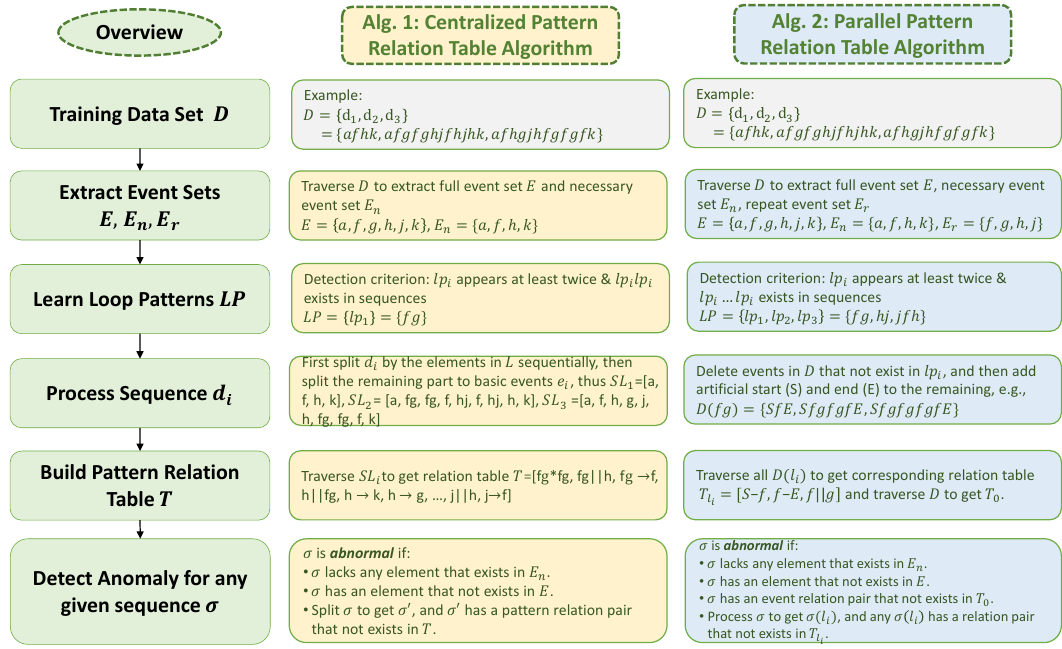
Figure 2. Overview of major steps in relation-based anomaly detection algorithms and introduce the main idea of each step in Algorithms 1 and